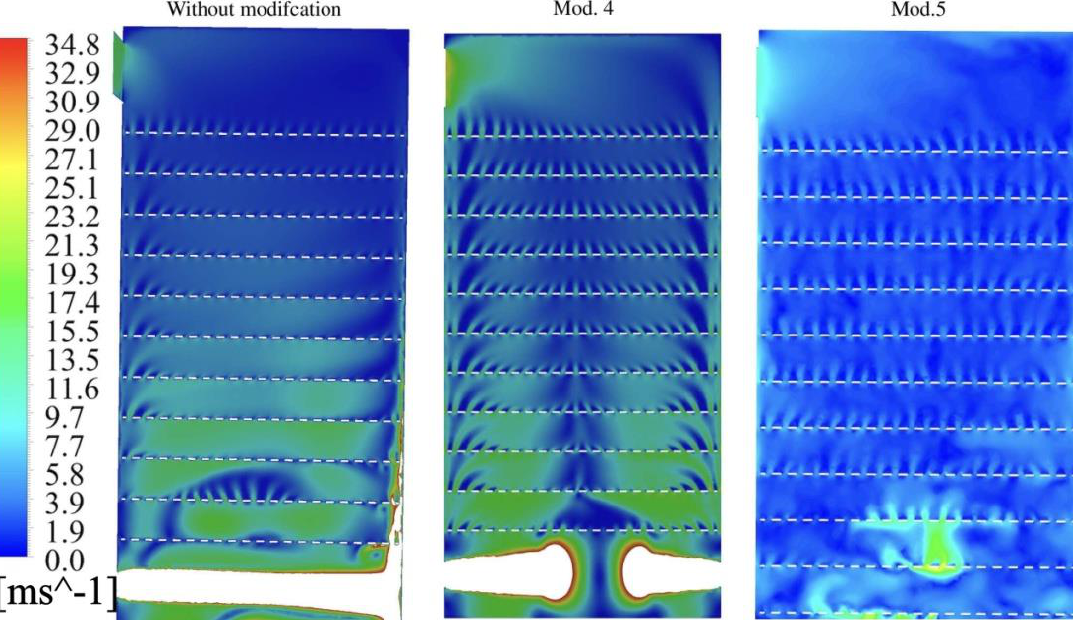
Figure 5. Velocity field visualization-comparison of 3 chambers.